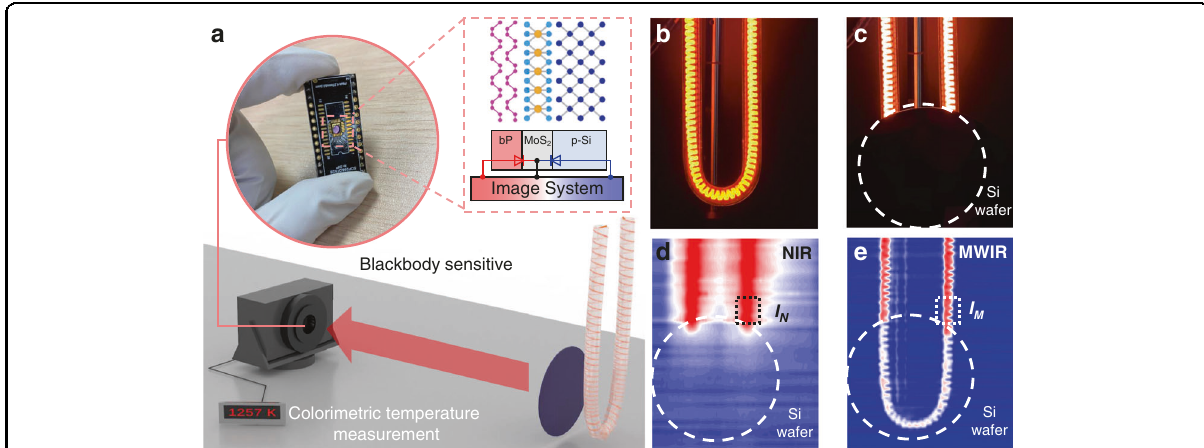
Fig. 4 Temporal-spatial coexisting two-color IR imaging. a Schematic diagram of simultaneous mode two-color imaging system. Inset: optical image of two-color vdWs infrared photodetector. b Photograph of target (carbon fi ber heating tube) was captured by a silica-based camera. c Photograph of target (carbon fi ber heating tube covered by silicon wafer) was captured by a silica-based camera. d NIR images of objects behind a silicon wafer. The black dotted circle marks the position of the silicon wafer. The white dotted box indicates the location of photocurrent I N extraction. e MWIR images of objects behind a silicon wafer. The white dotted circle marks the position of the silicon wafer. The white dotted box indicates the location of photocurrent I M